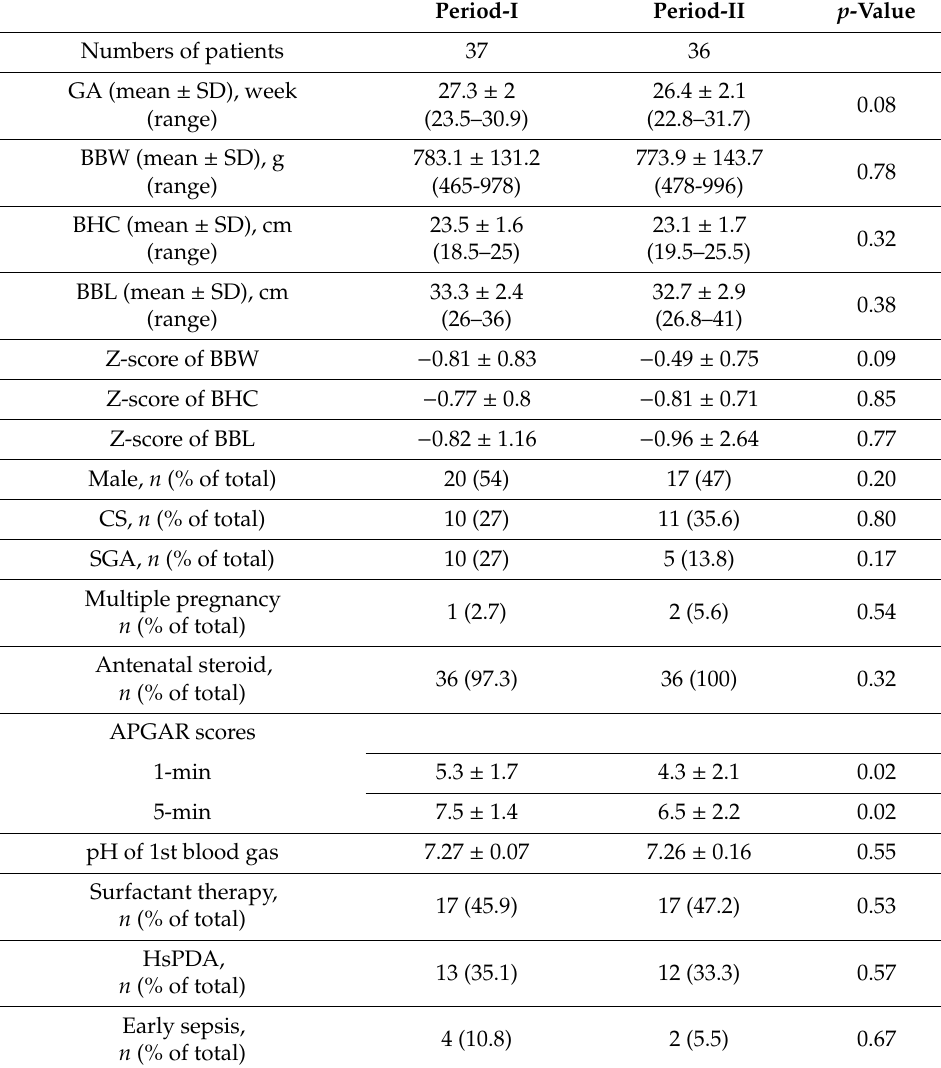
Table 2. The demographic, perinatal, and neonatal data of the two study